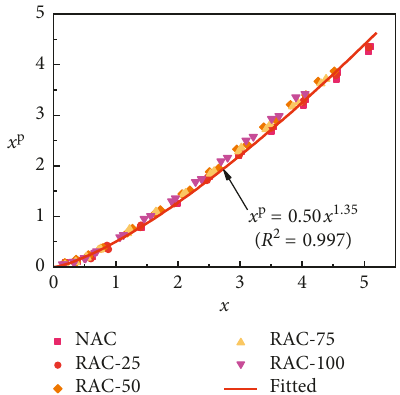
Figure 12: Relation between the plastic strain and the total strain of the RAC.